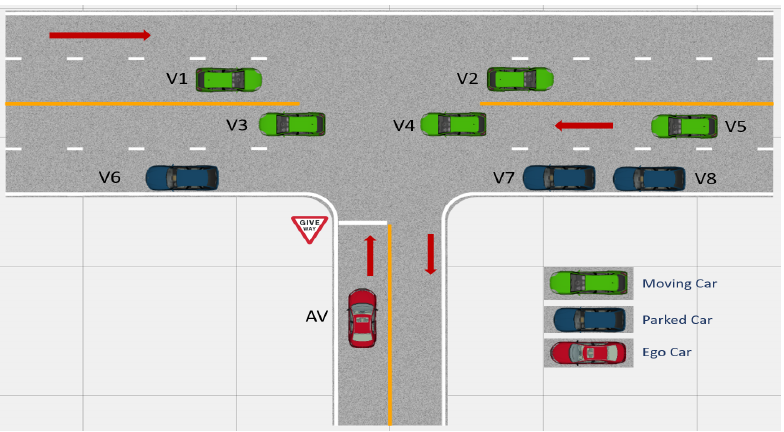
Figure 1. Test scenario for